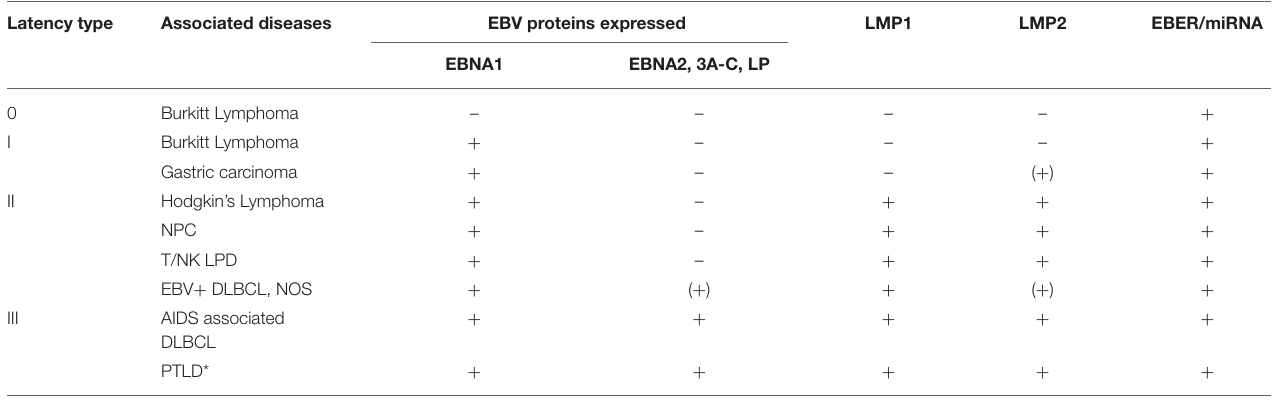
TABLE 1 | Latent viral protein expression patterns in EBV-associated